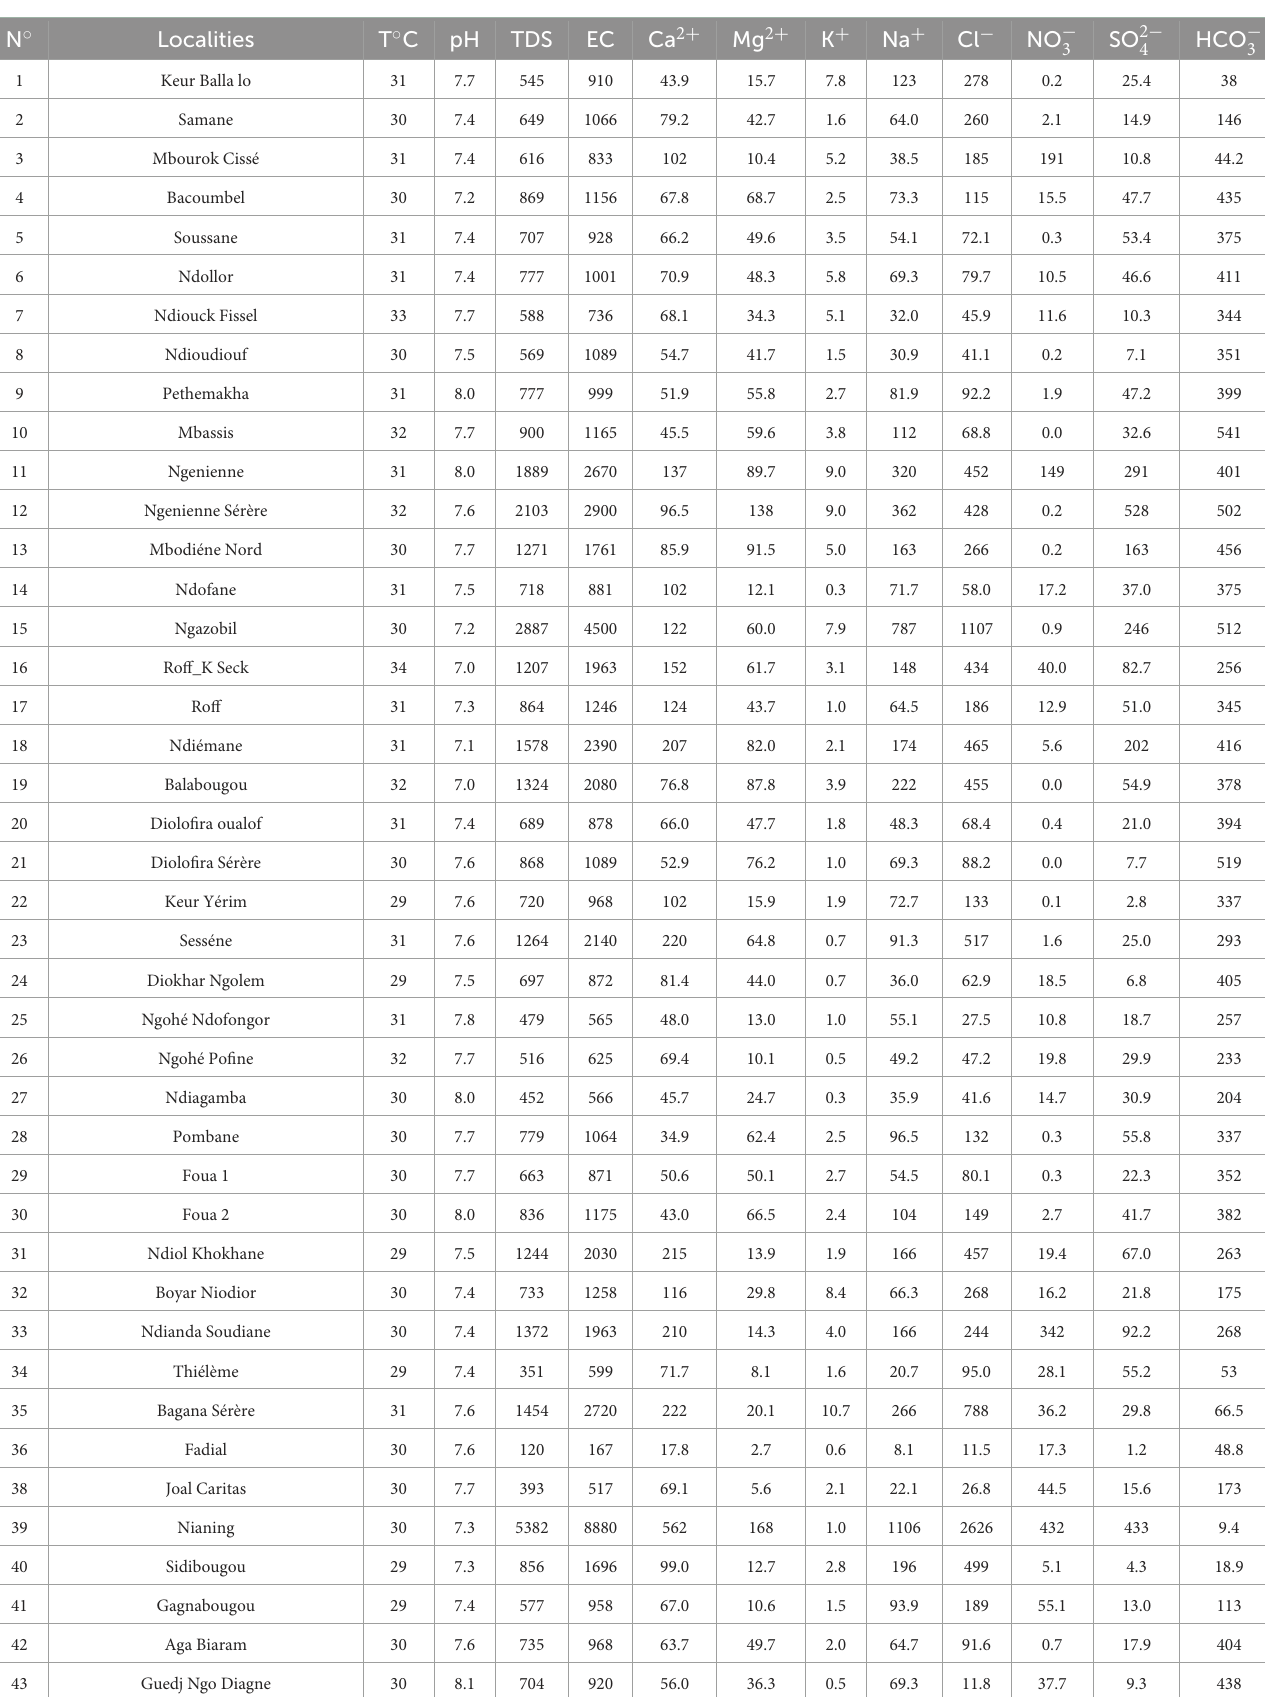
TABLE 1 Analytical results of groundwater samples from Mbour-Joal